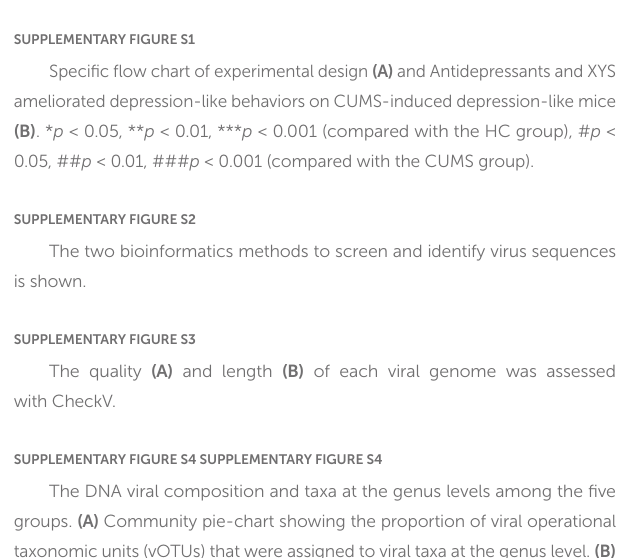
Specific flow chart of experimental design (A) and Antidepressants and XYS ameliorated depression-like behaviors on CUMS-induced depression-like mice